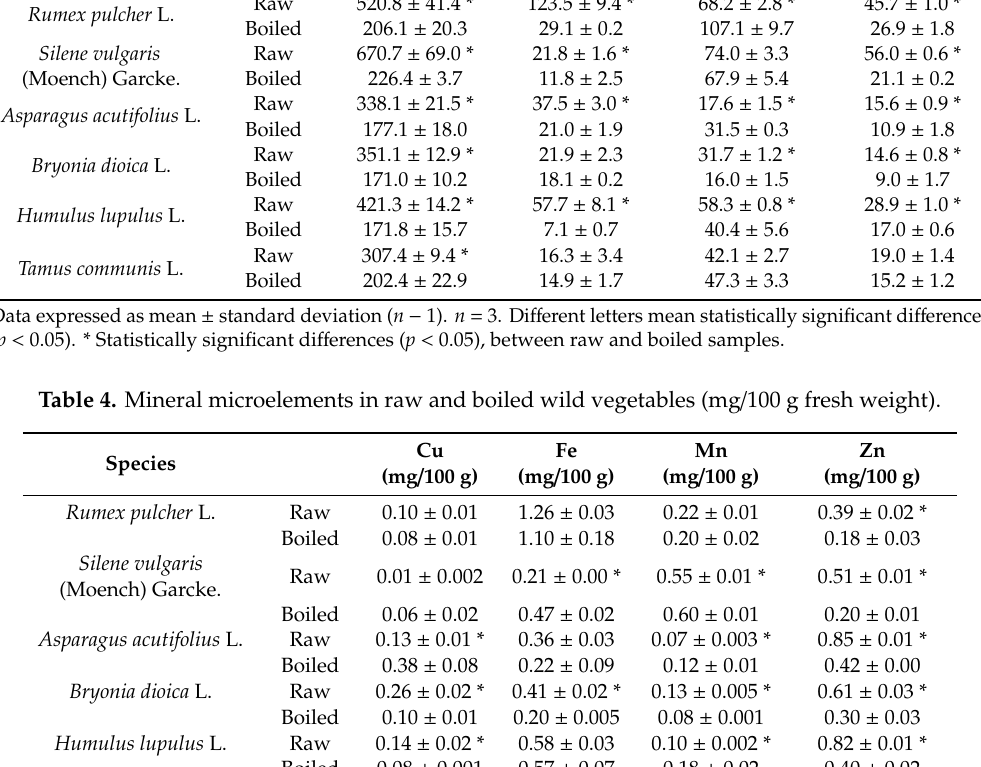
Table 2. The proximate composition of raw and boiled wild vegetables (g / 100 g fresh weight). Species Moisture Proteins Lipids TAC ± 0.1 * 2.70 ± 0.01 * 0.10 ± 0.02 * 1.54 ± 0.02 * Rumex pulcher L. Fresh 88.1 Boiled 90.8 ± 0.9 0.31 ± 0.02 0.03 ± 0.00 2.02 ± 0.12 4.41 ± 0.07 0.81 ± 0.01 Silene vulgaris Raw 86.1 ± 0.1 * 3.16 ± 0.09 * (Moench) Garcke. Asparagus Raw 86.9 ± 0.1 * acutifolius L. ± 0.1 * Bryonia dioica L. Raw 90.7 ± 0.1 * Humulus lupulus L. Raw 86.2 90.7 ± 0.2 0.56 ± 0.01 0.72 ± 0.01 Raw 88.7 ± 0.4 * Tamus communis L.